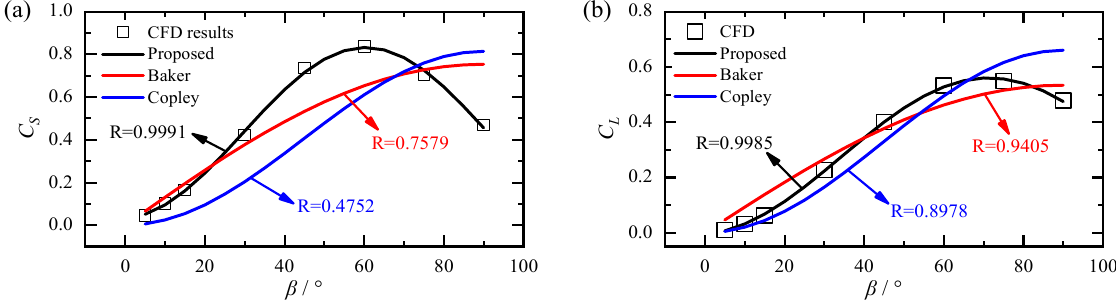
Figure 12. Comparison for the prediction results of the aerodynamic coefficient of the head car using different expressions: ( a ) side coefficients; ( b ) lift coefficients. Table 1. The fitted parameters for the force coefficient of the head car. Force